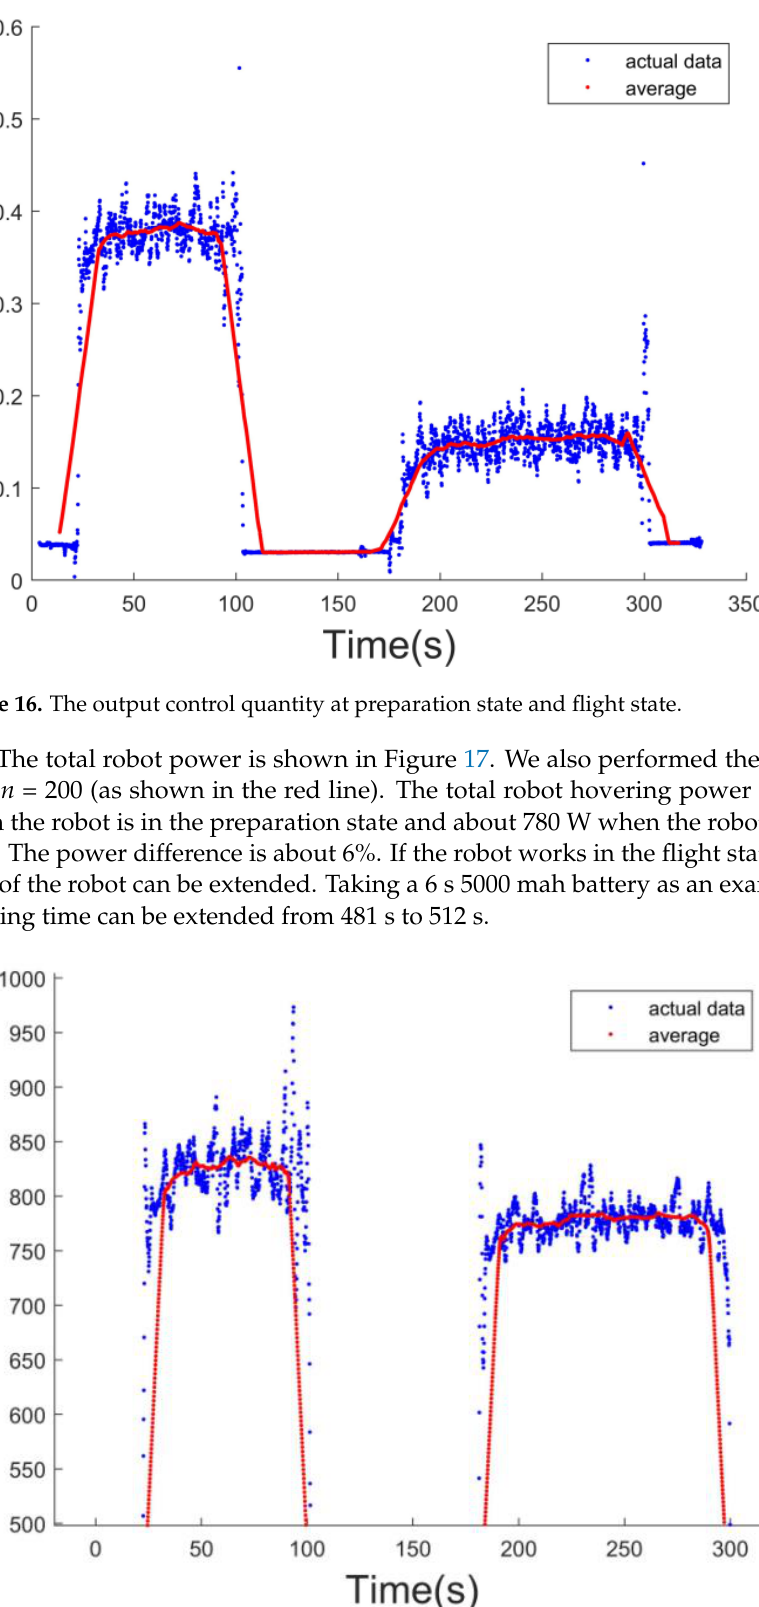
Figure 17. Total power at preparation state and flight state.